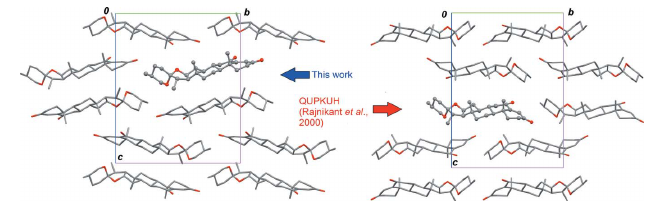
Figure 3 Comparison of the crystal structure for the new polymorph (left) with that previously reported (right). One molecule is chosen arbitrarily as the asymmetric unit and displayed in ball-and-stick style, in order to have roughly the same orientation with respect to cell axis in both forms. Projections are viewed down crystallographic a axis.